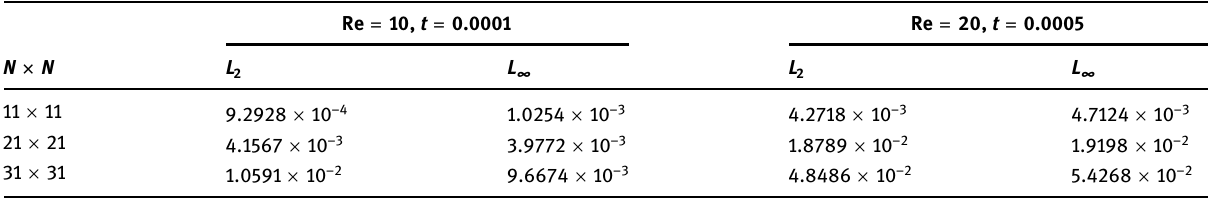
Table 13: Error norms at = t 0.0001 and = t 0.0005 for = Re 10 and 20, respectively, for = N 101